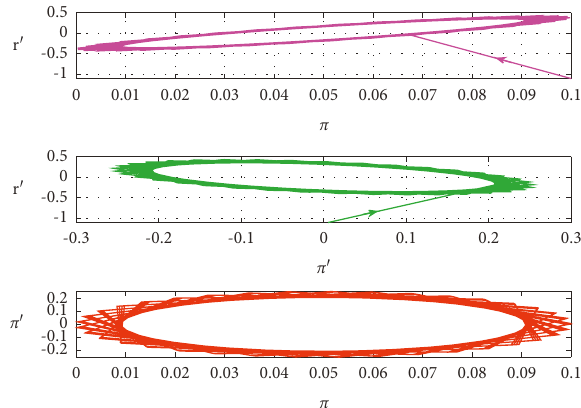
Figure 13: Three-dimensional phase portrait.